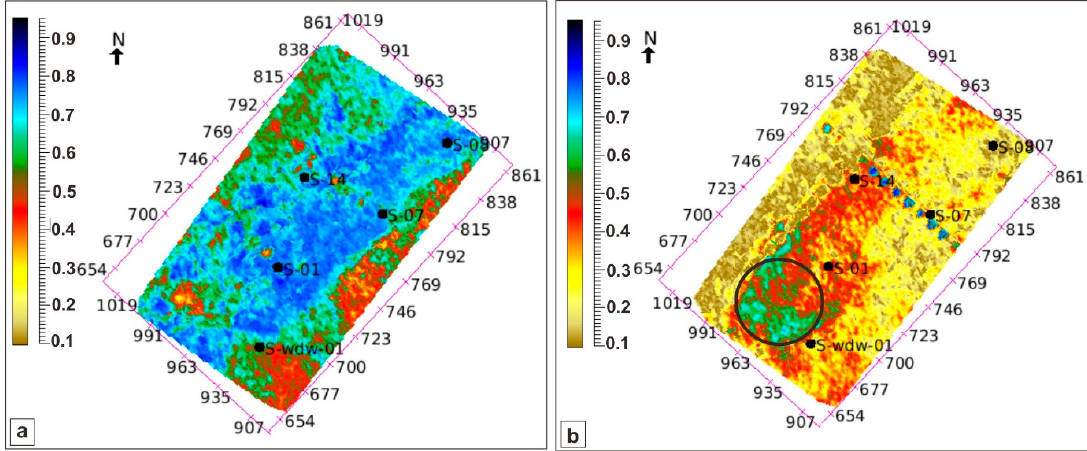
Figure 14. Sand-ratio distribution maps of ( a ) C-sand interval; ( b ) B-sand interval. The black circle shows the high sand-ratio region with no drilled well and can be exploited for future drilling.